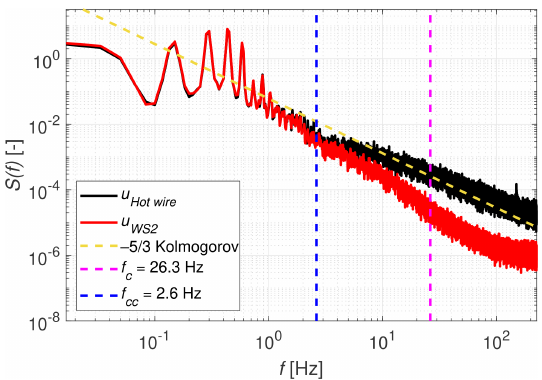
Figure 20. Spectrum of WindScanner 2 and the hot-wire anemome- ter for a coefficient of variation of 12.9% (Case 2c).